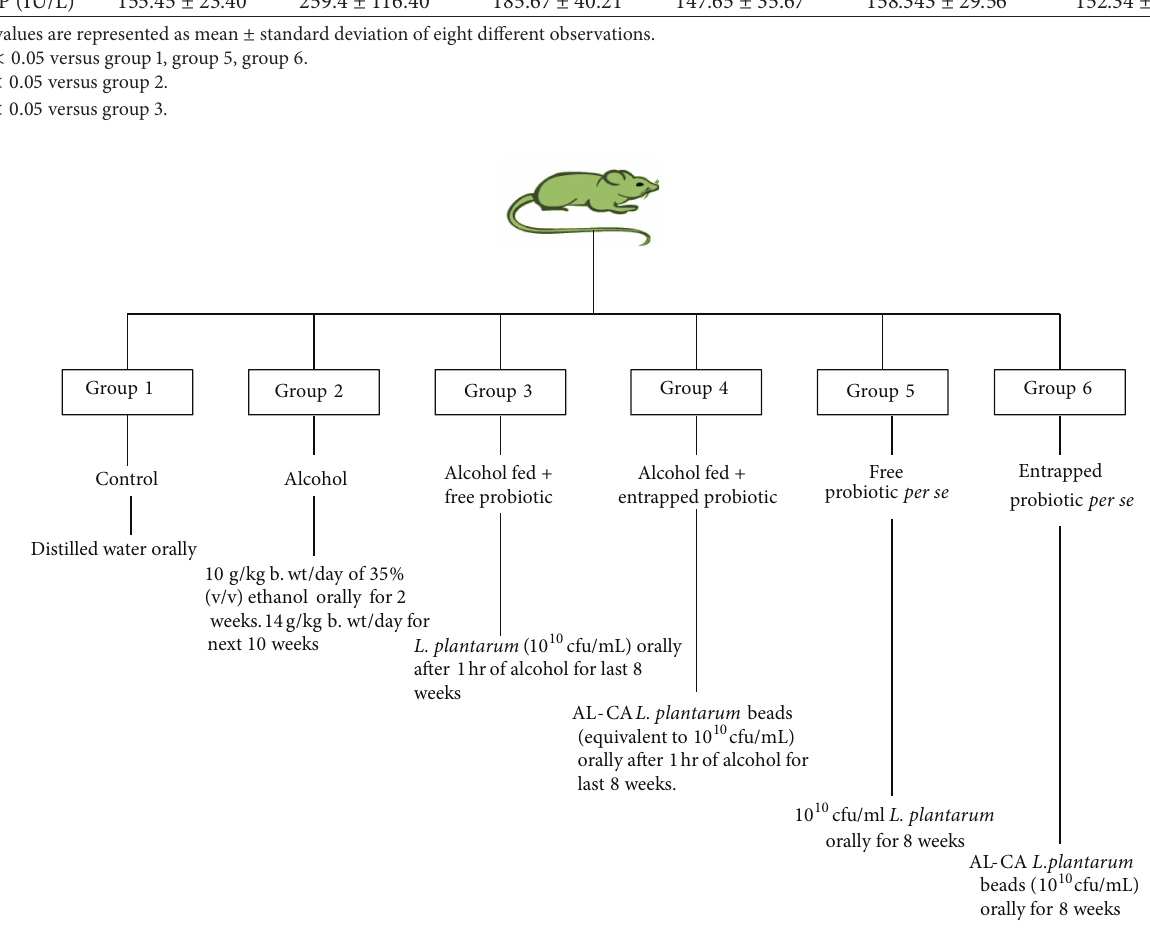
Figure 3: Diagrammatic representation of various treatment groups made for in vivo